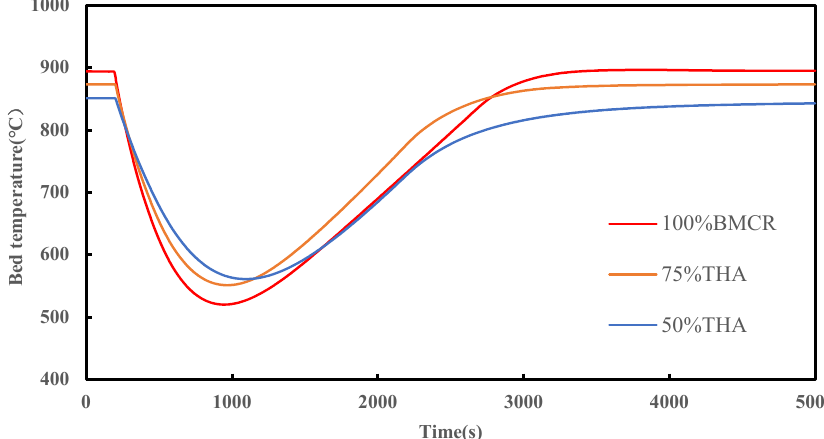
Figure 7. Response of bed temperature during MFT at different conditions.